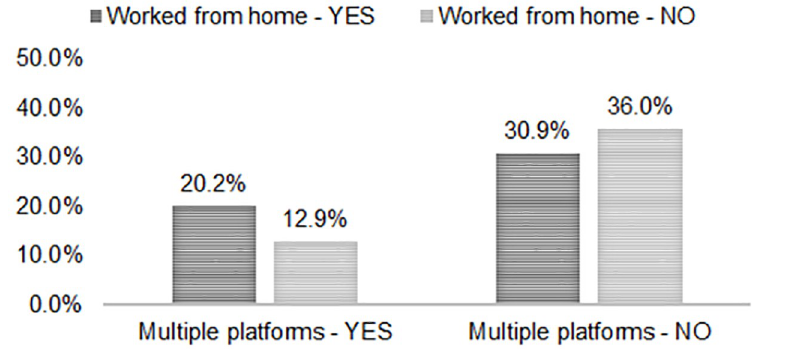
Fig 2. Multiple platforms use by working from home: Decreased alcohol use